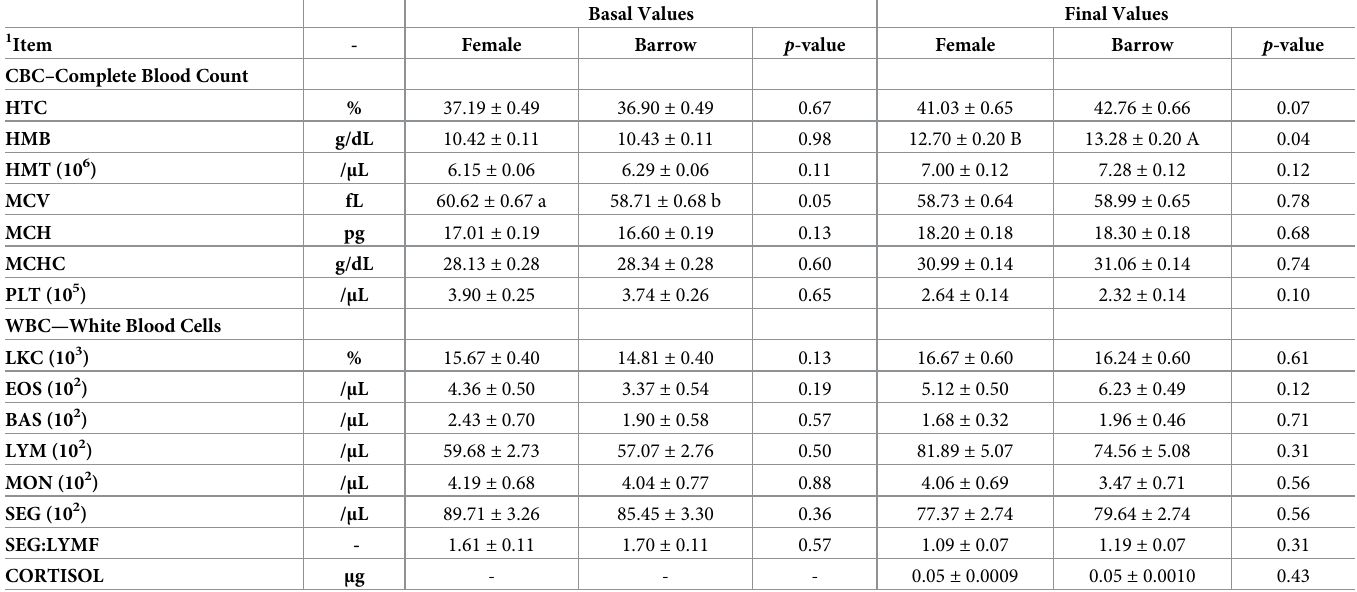
Table 9. Initial and final average blood count (mean ± SE) and cortisol samples (mean ± SE) of growing and finishing pigs according to